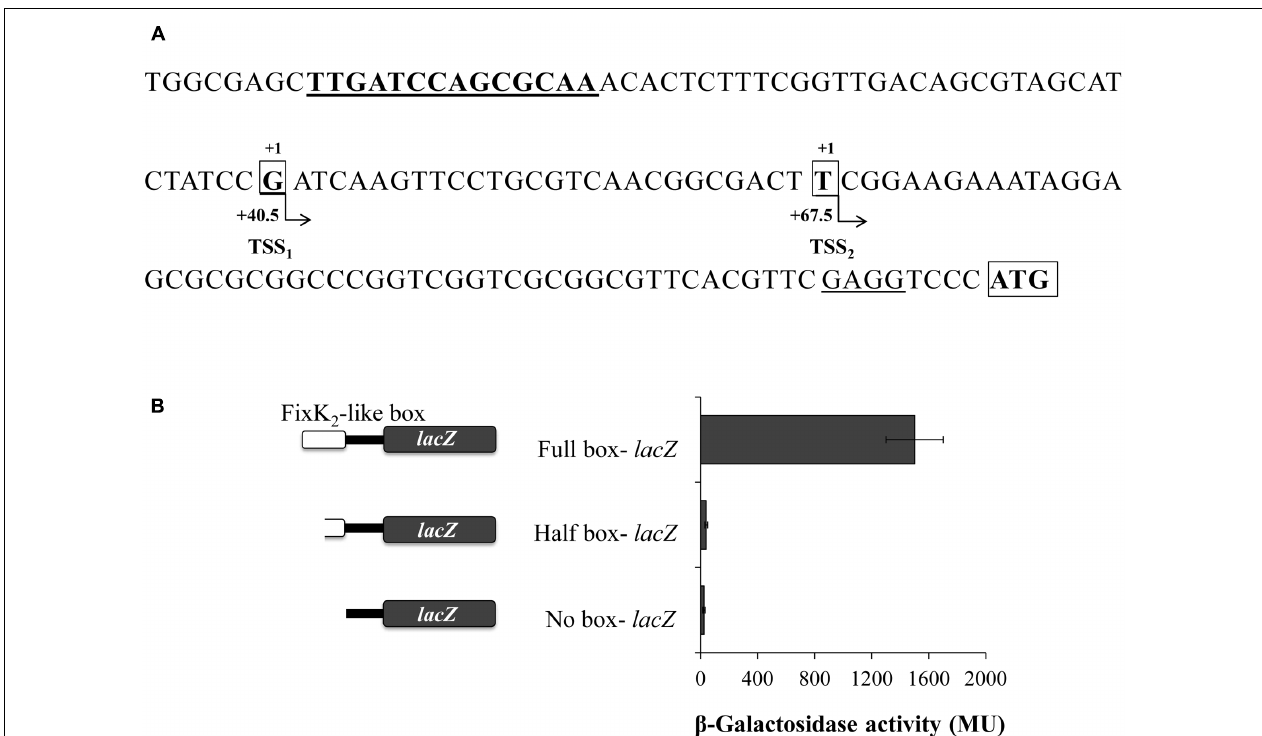
FIGURE 2 | Structure of the B. diazoefficiens nosR promoter. (A) Sequence and schematic representation of the nosR promoter region. Nucleotides corresponding to the transcription start sites (TSS) located at +40.5 and +67.5 bp from the axis of symmetry of the putative FixK 2 -like box (bold and underlined) identified by RACE are shown in bold, marked with “+1” above and highlighted with an open black box. The annotated nosR translation start codon (ATG; http://genome.annotation. jp/RhizoBase) is shown in bold with an open black box. A putative ribosome binding site of nosR is underlined. (B) β -Galactosidase activity from nosR-lacZ fusions containing different lengths of the FixK 2 -like box is indicated on the left side of the figure. Cells were cultured for 24 h under low oxygen conditions (0.5% O 2 ) with 10 mM KNO 3 . Data expressed as Miller units (MU) represent mean values and error bars from triplicate samples from at least two independent